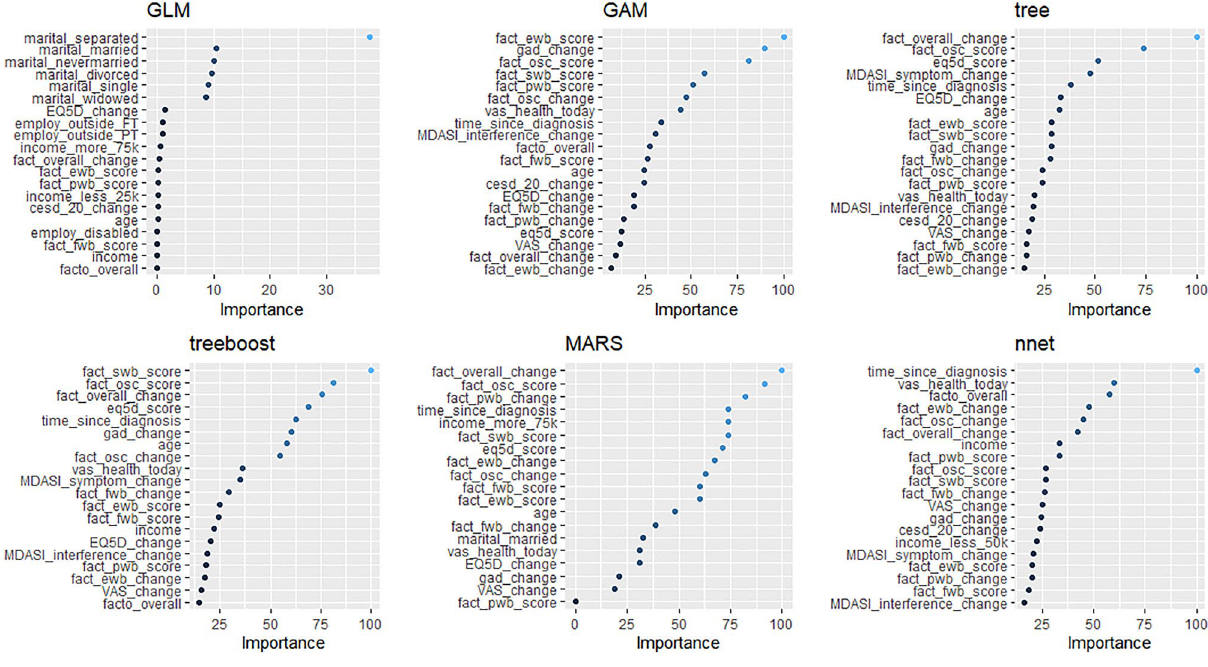
Figure 1. Variable importance